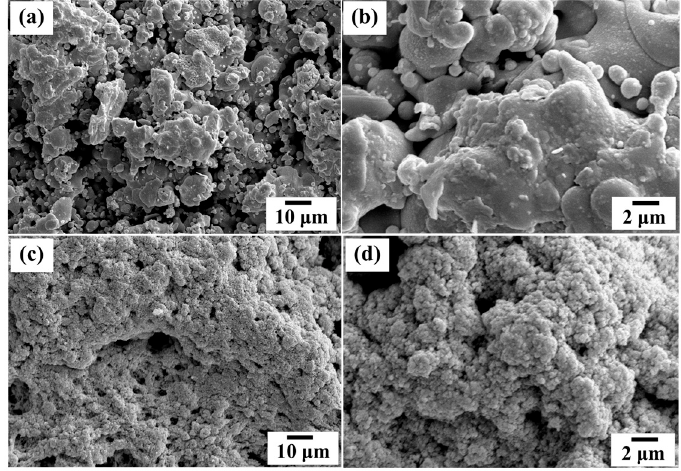
Figure 2. Field emission scanning electron microscopy (FESEM) images of the TiO 2 film surface fabricated by ( a , b ) thermal spray coating and ( c , d ) screen-printing.